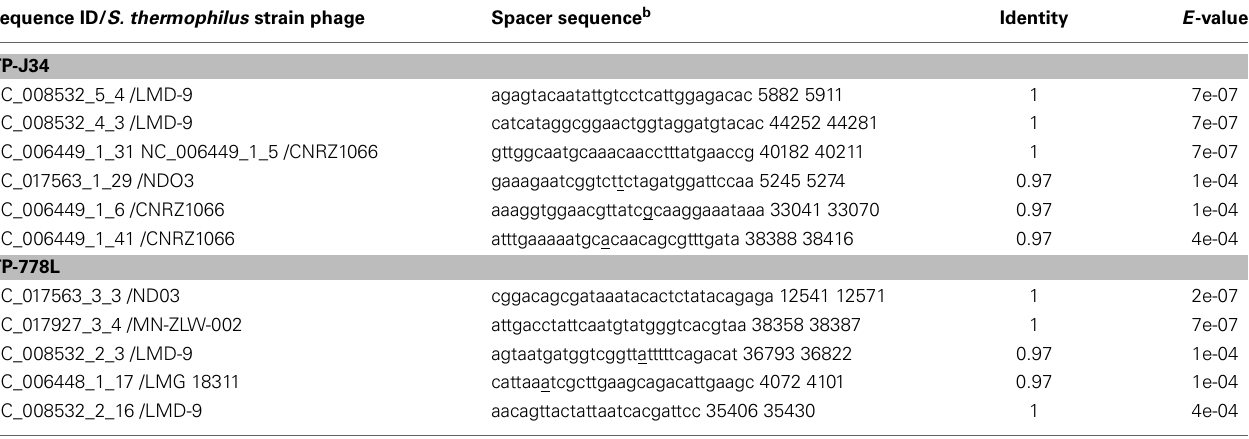
Table 2 | CRISPR spacer sequences present in genomes of TP-J34 and TP-778L a . Sequence ID/ S. thermophilus strain phage Spacer sequence b